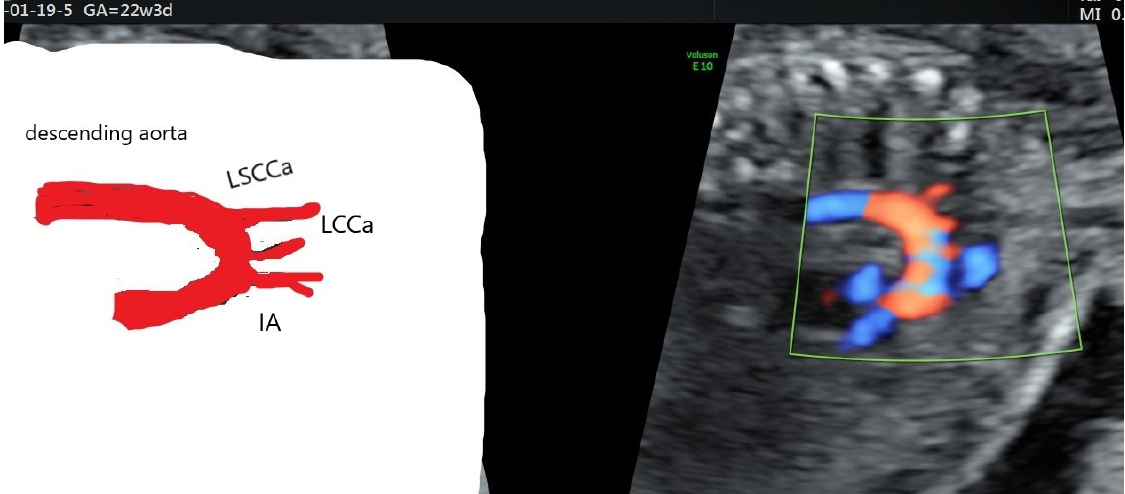
Figure 1. Schematic figure of normal (type I) aortic branching. Sagittal section of fetal thorax, spine anterior. Dao—descending aorta, IA—innominate artery (brachiocephalic trunk), RSCa—right subclavian artery, RCCa—right common carotid artery, LSa—left subclavian artery.